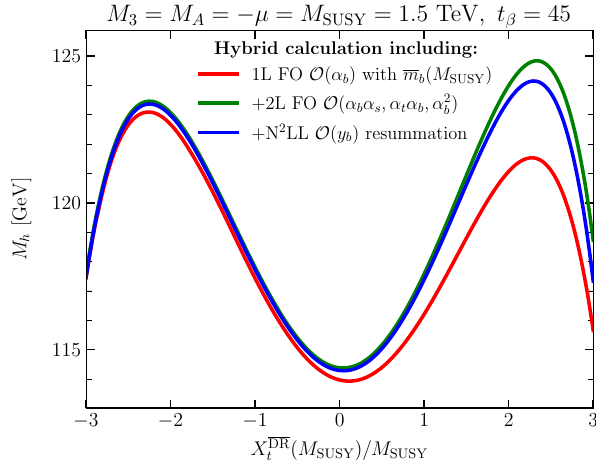
) corrections. The green ally included the fixed-order O (α b α s ,α b α t ,α 2 b lines contain additionally the resummation of logarithms proportional to the bottom Yukawa coupling up to the NNLL level